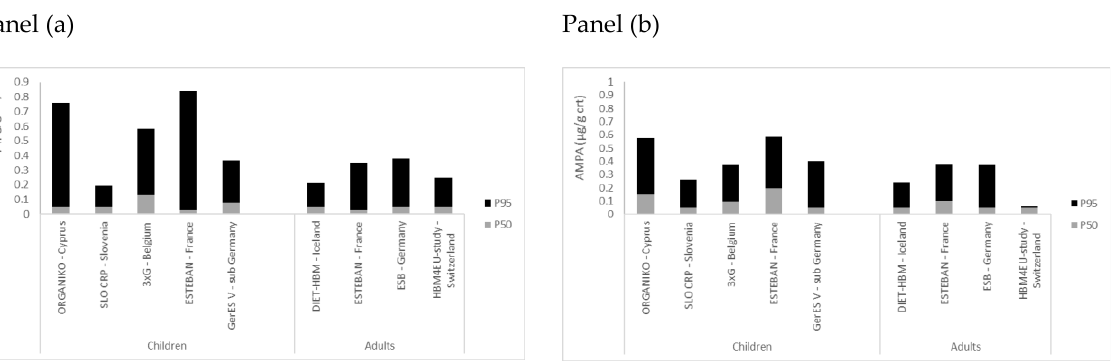
Figure 1. Glyphosate (Gly) and AMPA ( µ g/g crt) in adults and children of the aligned studies under HBM4EU. Panel ( a ) Gly and panel ( b ) AMPA. Data for children described in Buekers et al., 2022 [8]. Values below the LOQ were set at the LOQ/2 for presentation.